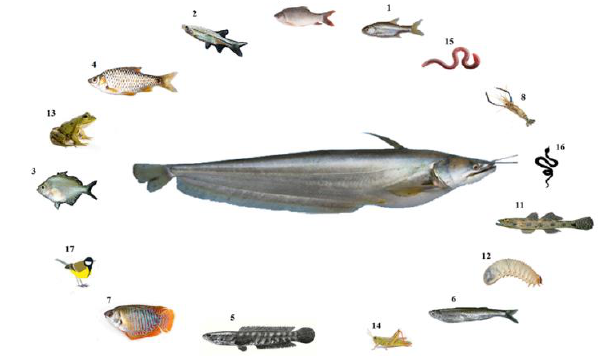
Figure 3: Predator-prey relation and the position of Attu fish in the tropic level in the aquatic ecosystem of river Keleghai recommended by fisher’s man.